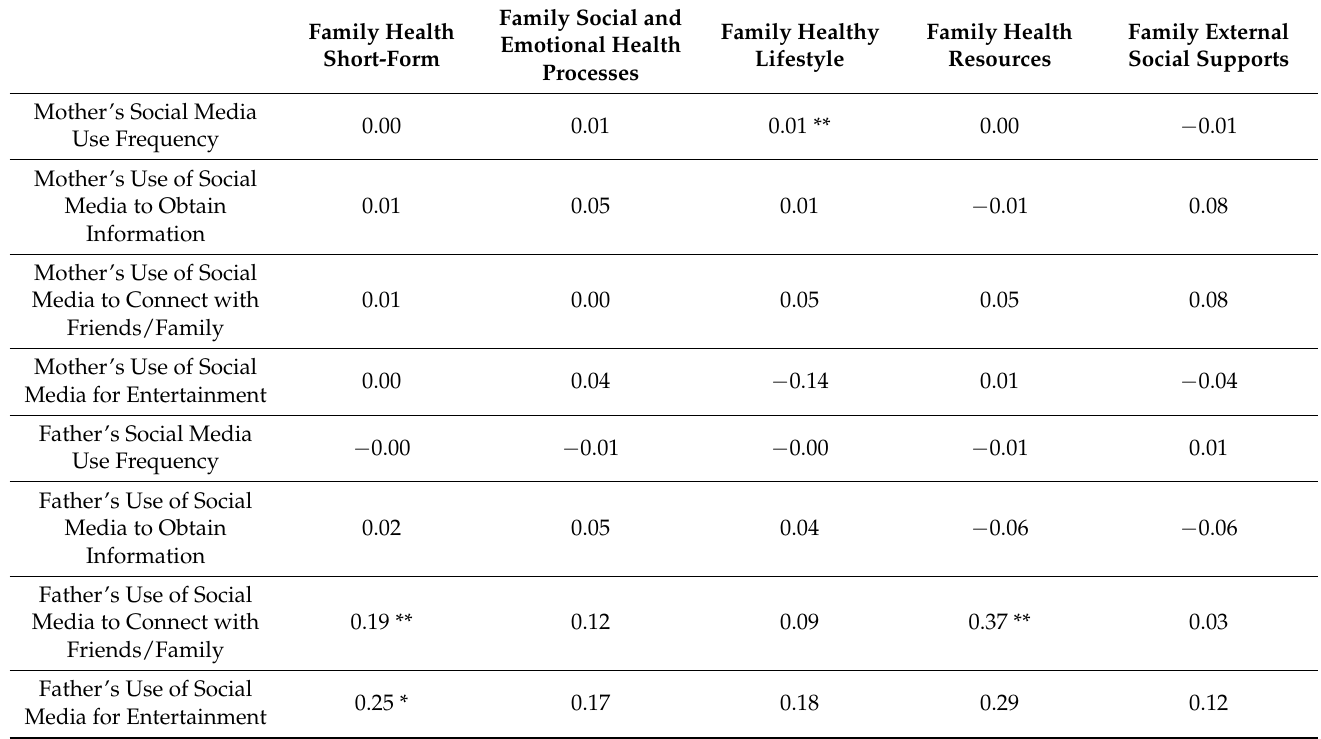
Table 4. Multiple linear regression results examining the associations of parental social media use and family health domains. Family Social and Family Healthy Family Health Family External Family Health Emotional Health Lifestyle Resources Social Supports Short-Form Processes 0.00 0.01 0.01 ** 0.00 −